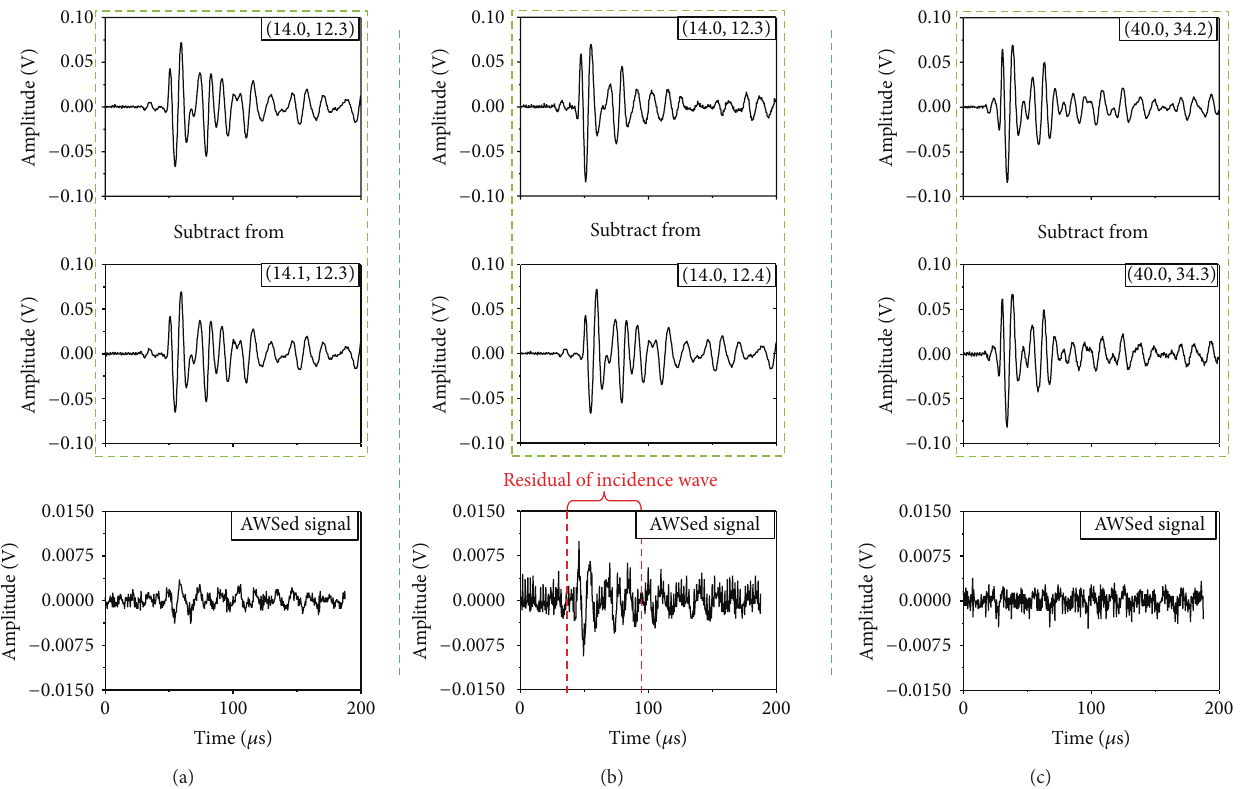
Figure 8: Adjacent wave subtraction process using signals obtained at (a) (14.0, 12.3) and (14.1, 12.3), horizontal AWS; (b) (14.0, 12.3), (14.0, 12.4), and vertical AWS on the surface crack; and (c) (40.0, 34.2), (40.0, 34.3), and vertical AWS on the intact